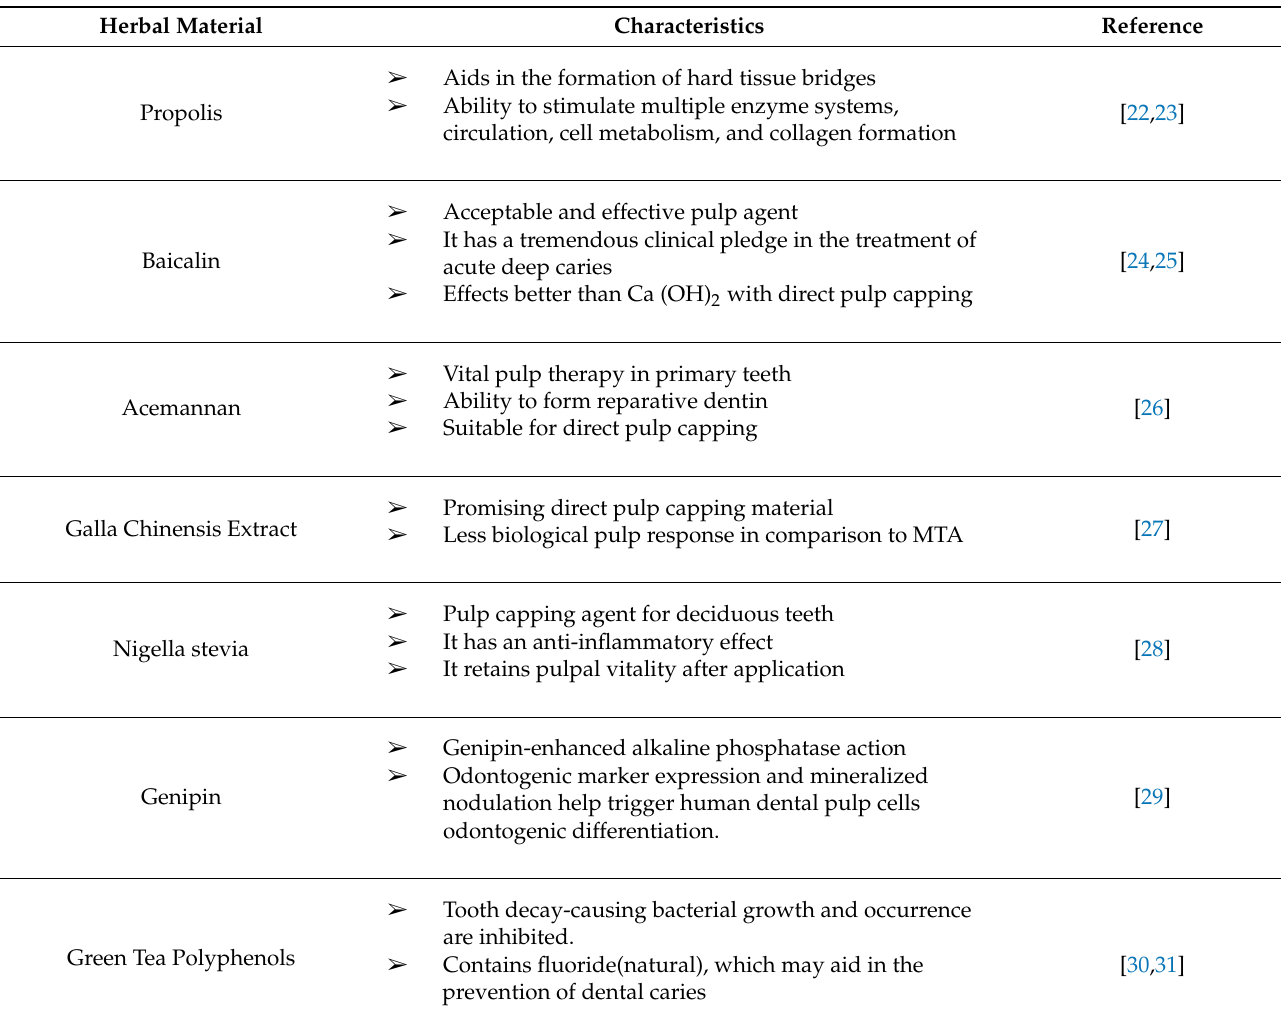
Table 2. Studies related to the use of herbal medicine for pulp and dentin